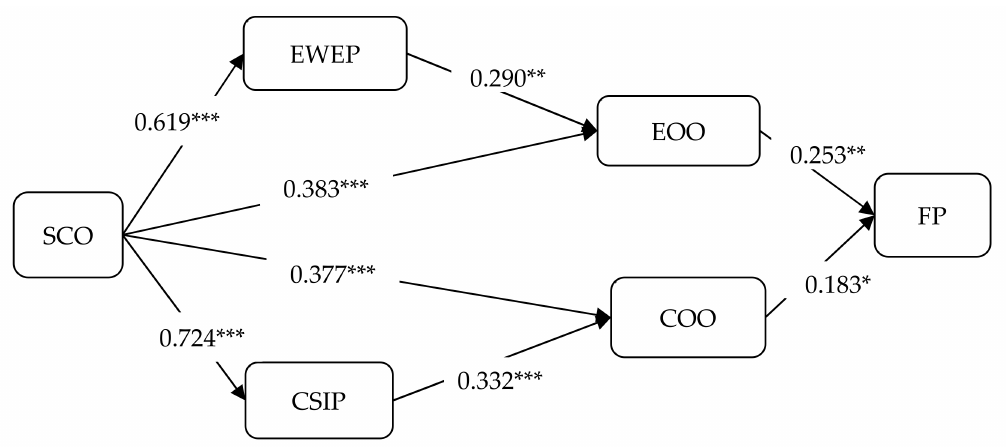
Figure 1. SEM results. SCO: social orientation of the firm; EWEP: employee well-being and equity practices; CSIP: corporate social involvement practices; EOO: employee-oriented outcomes; COO: community-oriented outcomes; FP: financial performance. * p < 0.05, ** p < 0.01, and *** p < 0.001. H1a and H1b propose that the SCO is positively associated with EWEP and CSIP. The SEM results show that the SCO have significantly positive impacts on EWEP (path coefficient = 0.619, p < 0.001) and CSIP (path coefficient = 0.724, p < 0.001), supporting H1a and H1b. H2a and H2b proposed that the SCO is positively associated with EOO and COO. The results indicate that the SCO has significantly positive impacts on EOO (path coefficient = 0.383, p < 0.001) and COO (path coefficient = 0.377, p < 0.001), supporting H2a and H2b. H3, proposing that EWEP is positively related to EOO, is supported (path coefficient = 0.290, p < 0.01). H4, proposing that CSIP is positively related to COO, is supported (path coefficient = 0.332, p < 0.001). H5 and H6 predict that EOO and COO are positively associated with FP. Our results show that both EOO (path coefficient = 0.253, p < 0.01) and COO (path coefficient = 0.183, p < 0.05) have significantly positive impacts